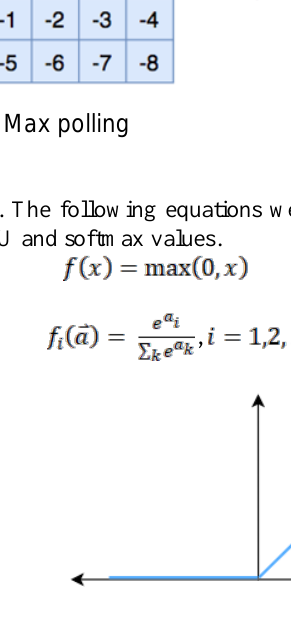
Fig. 4. ReLU plot for negative and positive